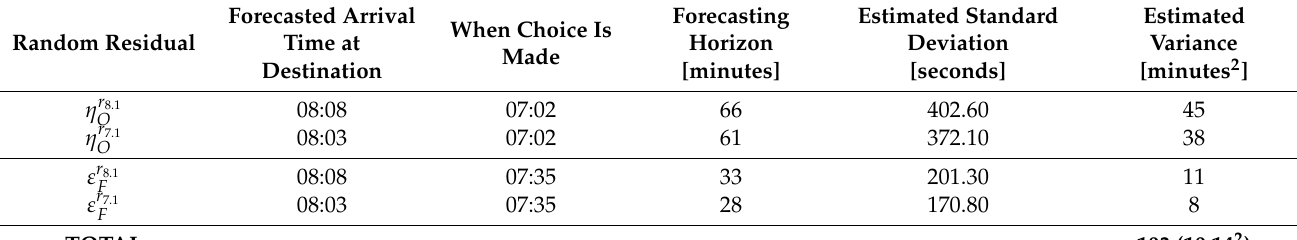
Table 3. Estimation of residual variance according to the forecasting horizon (refer to Figure 6).